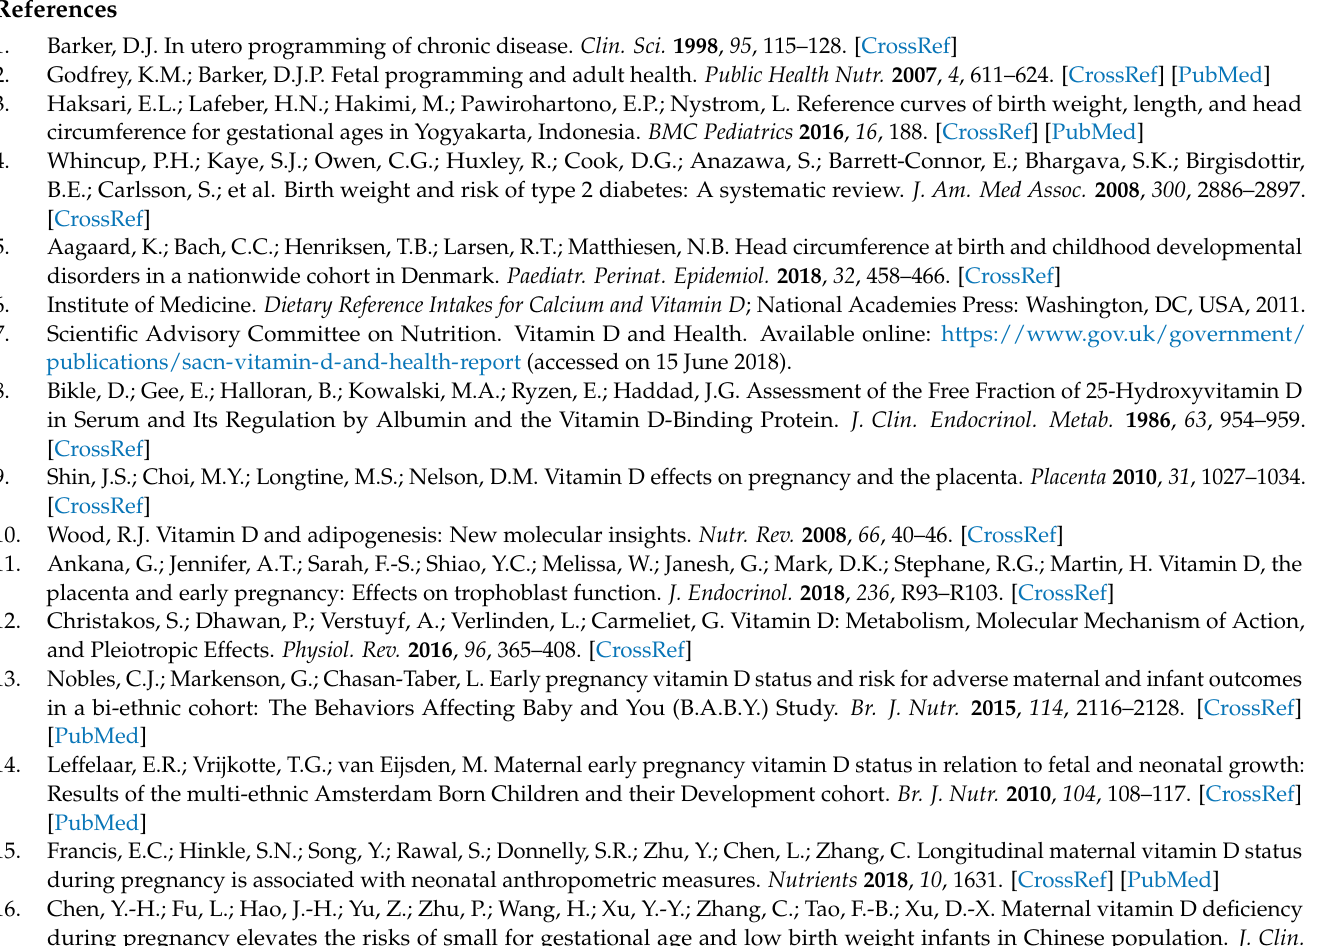
and crown–heel length according to neonatal vitamin D status; Figure S1: Schematic representation of the metabolism of vitamin D in mothers, placenta and